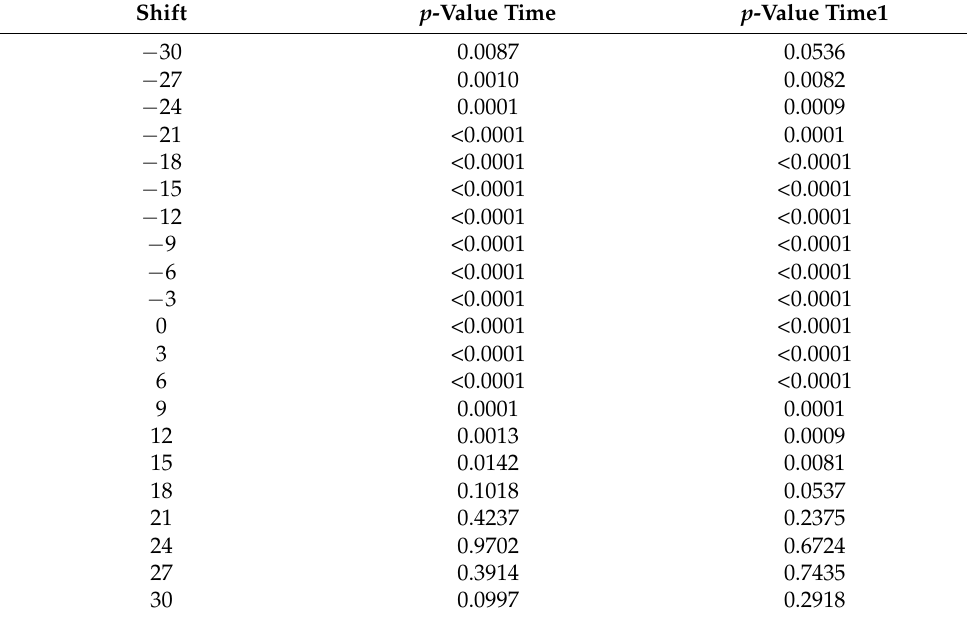
Table 4. Tipping point sensitivity analysis with p -values for time effects with shifts ranging from − 30 to